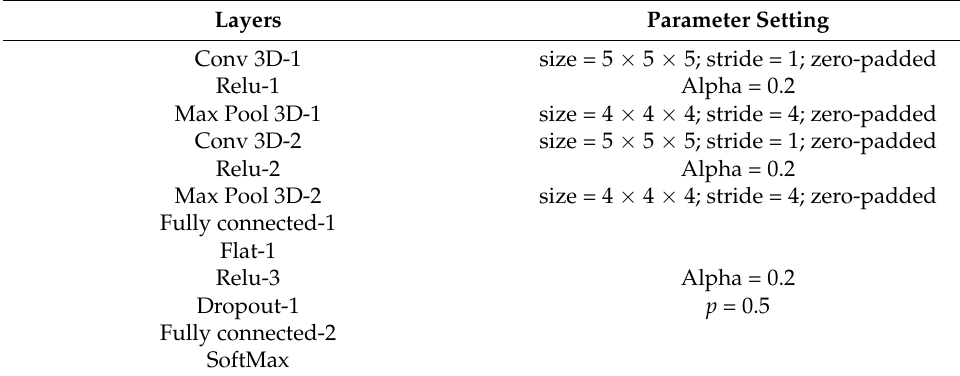
Table 1. 3D-CNN Architecture for extraction of deep learning